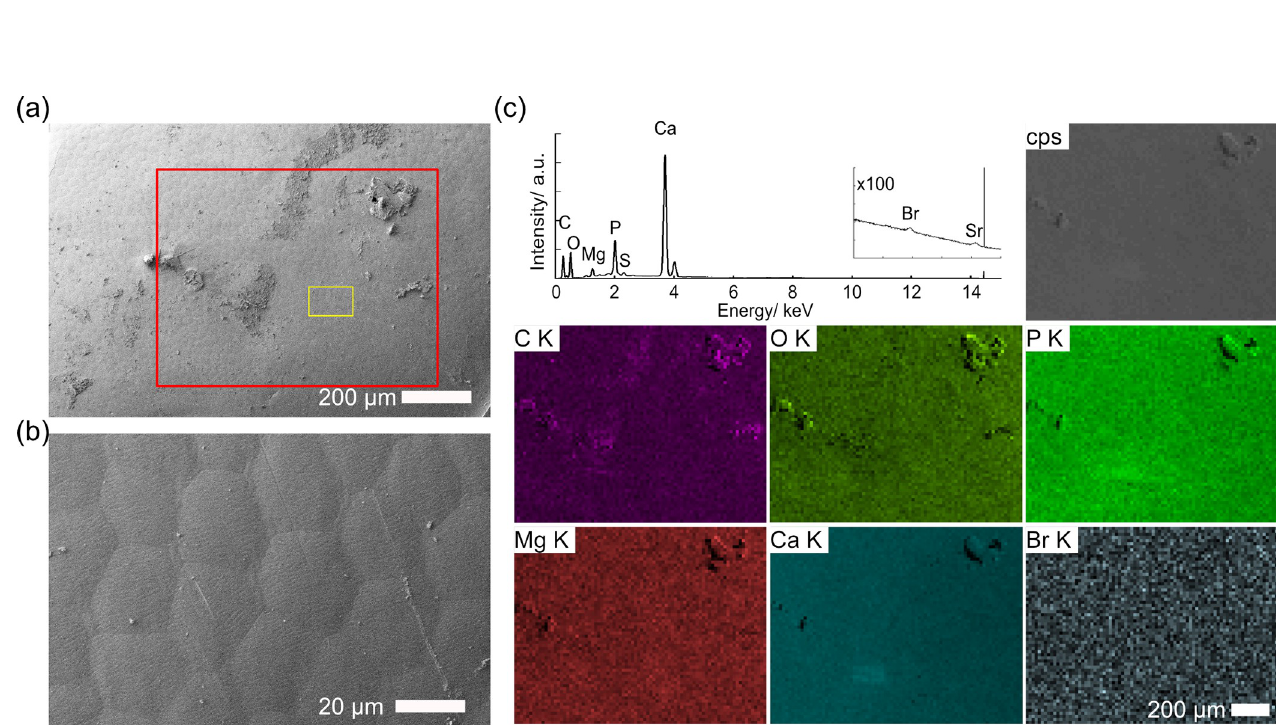
Fig 10. SEM/EDS images of a coxal plate of Hirondellea gigas . a) Low-magnification SEM image. b) Magnified image of the yellow rectangle in part (a). c) EDS elemental mapping and sum spectrum of the red rectangle in part (a).